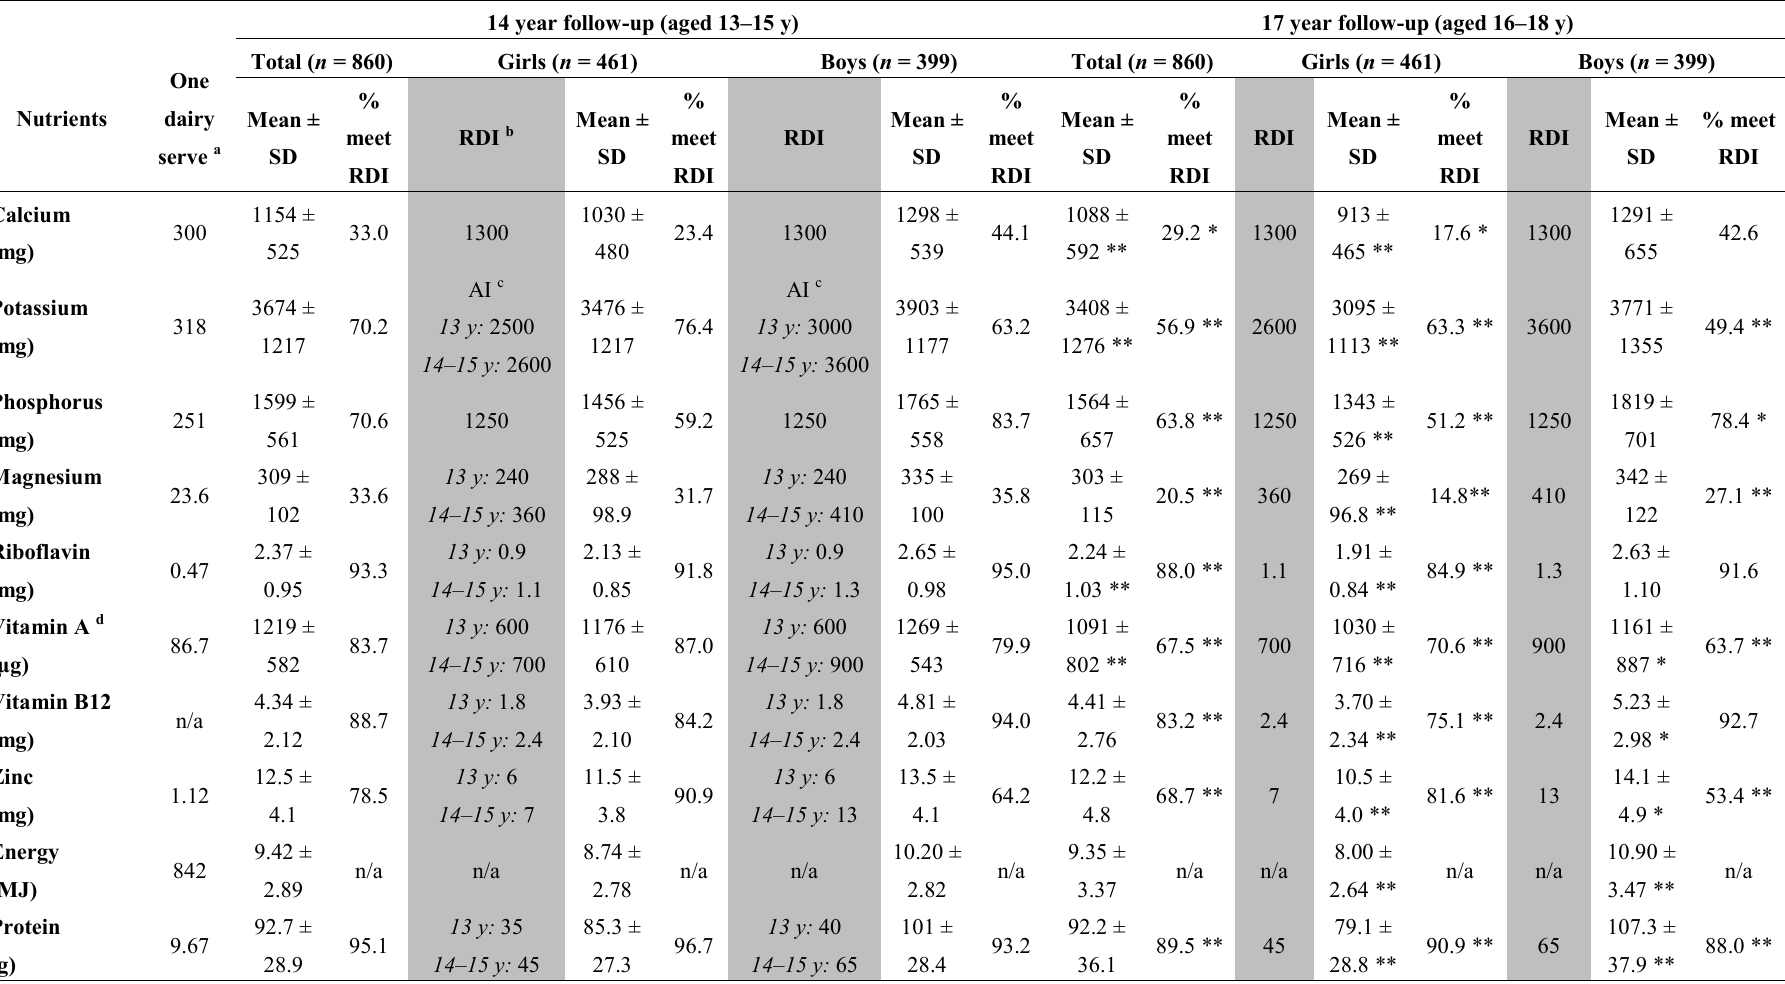
Table 1. Micro and macronutrient intakes for 14 and 17 year Raine study follow-up participants compared to Recommended Daily Intake (RDI) according to gender and age in years